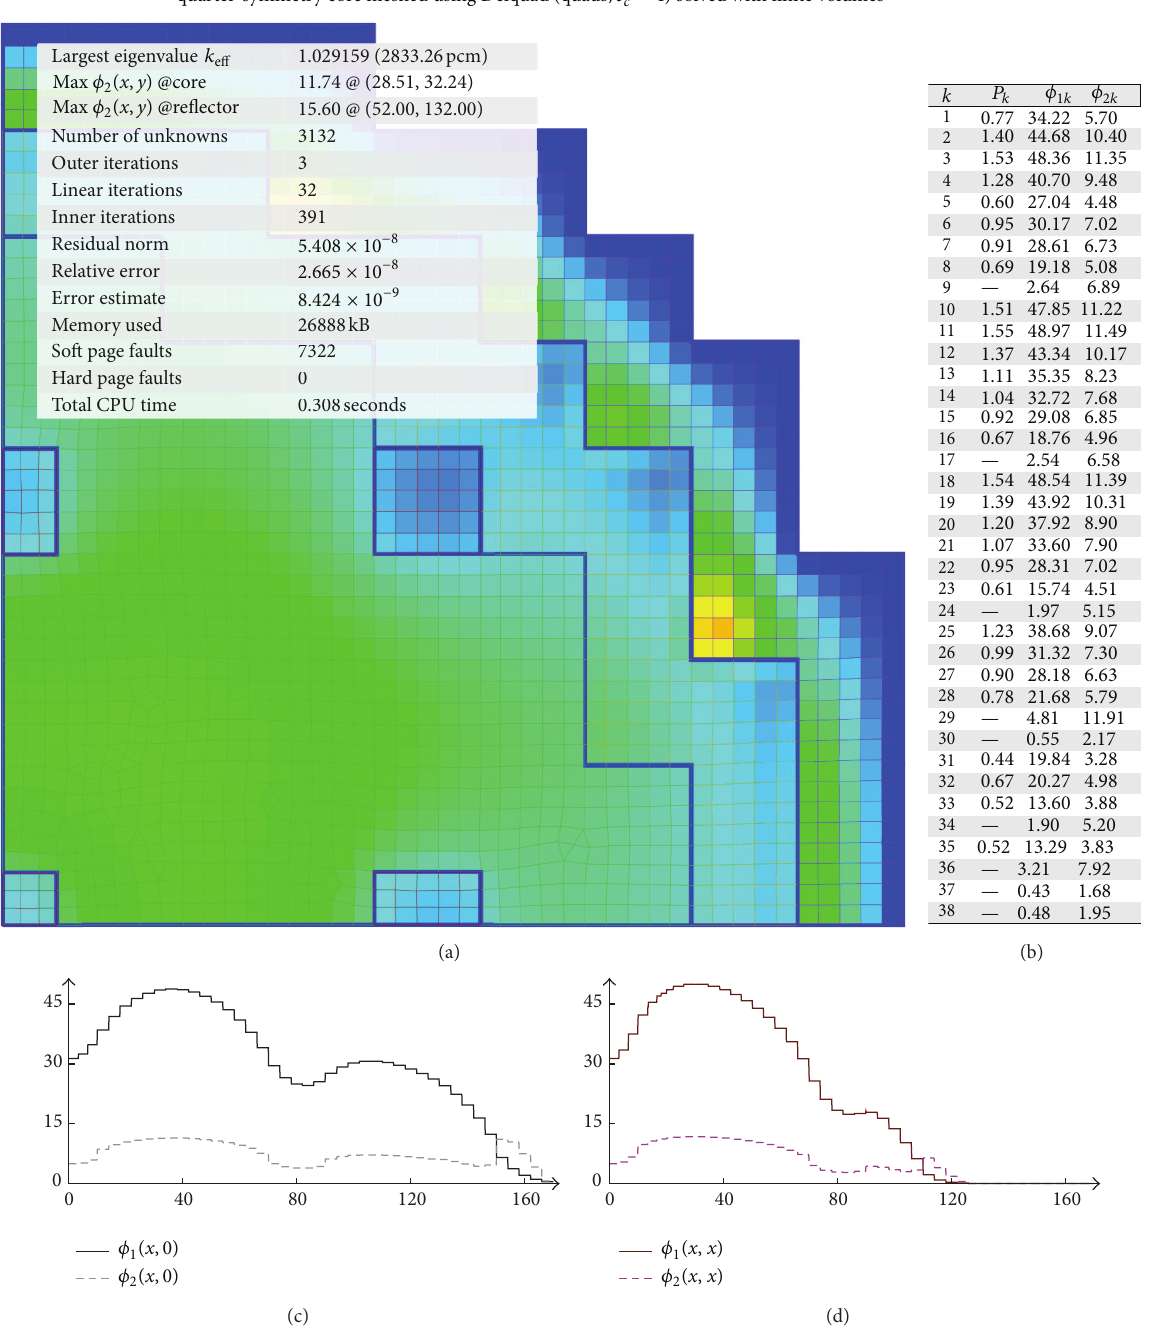
Figure 13: (a) Mesh and thermal flux distribution. (b) Power and fluxes. (c) Flux distribution 𝜙 𝑔 (𝑥,0) along the 𝑥 -axis. (d) Flux distribution (𝑥,𝑥) along the 𝜙 𝑔